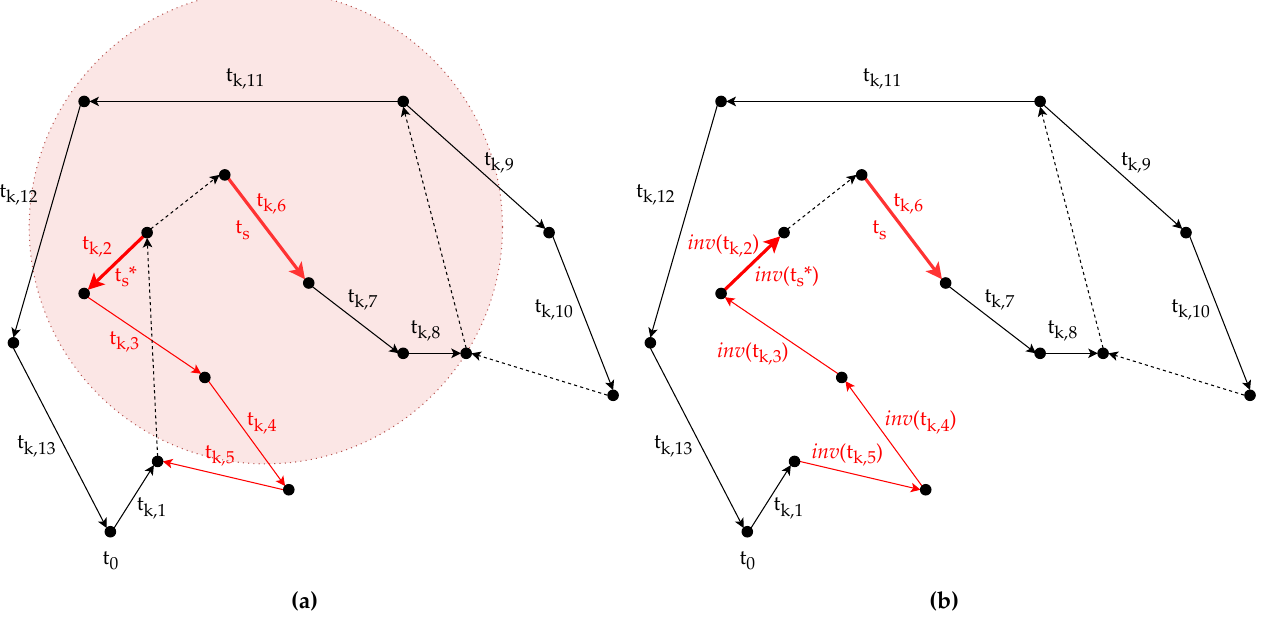
Figure 5. Rotation of the sub-route plan enclosed by t k , s ∗ and t k , s : ( a ) An arc task (here t k ,2 ) is randomly selected as t k , s ∗ from the neighbor list of arc task t k , s ( t k ,6 ), thus a sub-route plan is obtained; ( b ) The sub-route plan is inverted, so inv ( t k , s ∗ ) will be directly followed by t k , s in the new route plan r (cid:48)